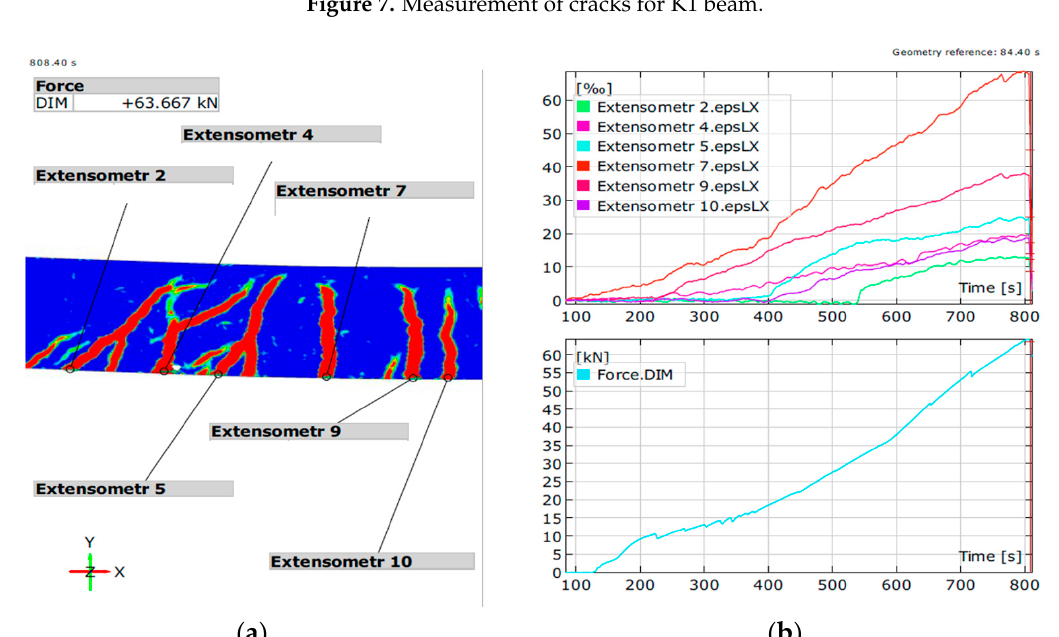
Figure 8. Measurement of cracks for K2 beam. ( a ) crack generation map during the test; ( b ) values of deformations (crack width) in each point at any given